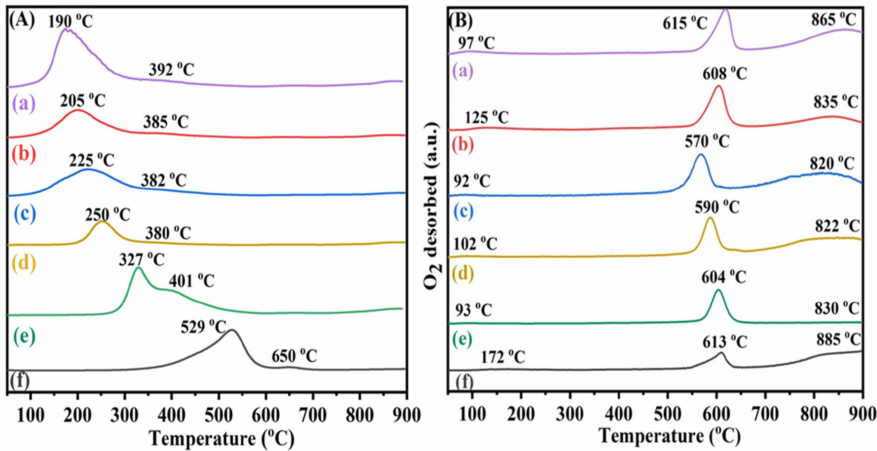
Figure 6. ( A ) H 2 -TPR profiles and ( B ) O 2 -TPD profiles of (a) 0.46PdPt 2.10 /V 2 O 5 -TiO 2 , (b) 0.41PdPt 0.85 /V 2 O 5 -TiO 2 , (c) 0.49PdPt 0.44 /V 2 O 5 -TiO 2 , (d) 0.47Pt/V 2 O 5 -TiO 2 , (e) 0.39Pd/V 2 O 5 - TiO 2 , and (f) V 2 O 5 -TiO 2